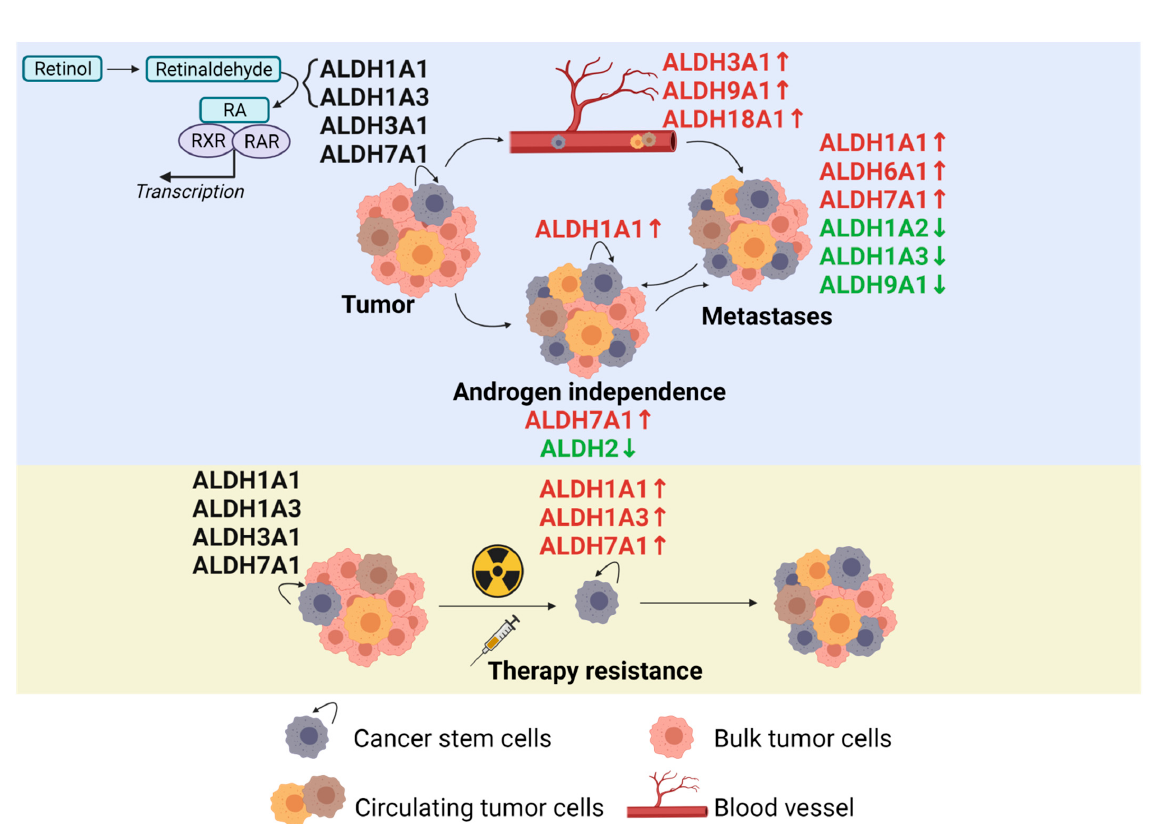
Figure 2. The role of the ALDH proteins in prostate cancer development, metastatic spread, and therapy resistance according to the current state of the literature. Created with BioRender. 2. ALDH1A1 ALDH1A1 represents the most investigated isoform of all of the ALDH genes. To- gether with ALDH1A2, ALDH1A3, and ALDH8A1, it belongs to the retinal metabolizing enzymes, contributing to the synthesis of retinoic acid. A high activity of aldehyde de- hydrogenases is a feature of normal and cancer stem cells that allows the detoxification of reactive oxygen species, specifically aldehydes, and can be measured by ALDEFLUOR assay. ALDH + cancer cells also possess abilities for self-renewal and differentiation. ALDH1A1 and ALDH1A3 were recognized as the main contributors to ALDEFLUOR enzymatic activity in prostate cancer cells (Figure 1) [23,42,43]. ALDH1A1 is a marker for normal and cancer stem cells of various tissue types, including a healthy and a cancerous prostate [44–47]. Li and co-authors found that ALDH1A1 + cells make only a small subset of CD44 + cell population in a basal component of normal prostate tissues. This study also demonstrated that ALDH1A1 highly expresses in prostate cancer tissues, including se- cretory epithelial cells and neuroendocrine cells [47]. Similar results were obtained in a tissue microarray study on Iranian patients, indicating an increased ALDH1A1 expres- sion in PCa over prostatic intraepithelial neoplasia (PIN) and benign prostatic hyper- plasia (BPH) samples. The authors also found that ALDH1A1 expressing cells appeared more frequently in samples with higher prostate-specific antigen (PSA) levels and a higher Gleason score [48]. Oppositely, two studies showed that ALDH1A1 expression is not significantly ele- vated between primary PCa samples, BPH, and a healthy prostate [49,50]. Nevertheless, the study of Le Magnen et al. also showed that within the PCa samples, higher